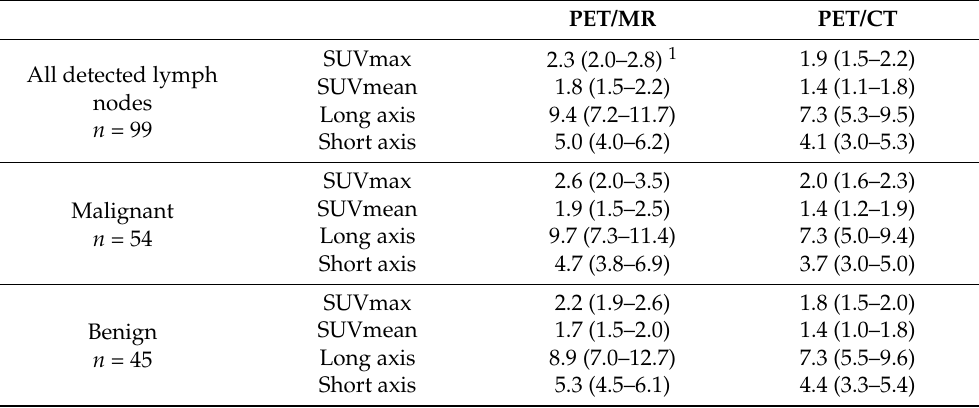
Table 5. SUVs, diameters of lymph nodes detected by both PET/MR and